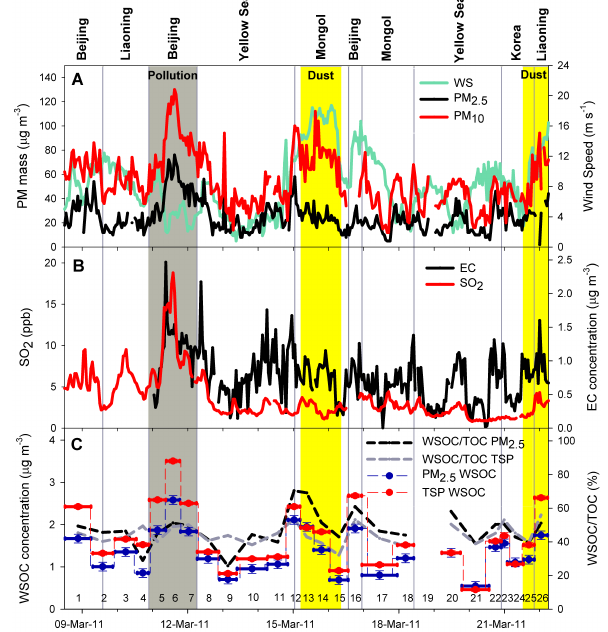
Fig. 2. Pollutant tracers and water-soluble organic carbon concen- trations during the March 2011 GoPoEx campaign at KCOG: ambi- ent air particulate mass (PM 2 . 5 and PM 10 ) and wind speed (A) ; con- centrations of SO 2 provided by South Korean National Institute of Environmental Research (NIER) and semi-continuously measured elemental carbon (EC) (B) ; concentrations of water-soluble organic carbon (WSOC) and WSOC to total organic carbon (TOC) ratio (C) in both ambient total suspended particles (TSP) and PM 2 . 5 fractions at KCOG during the GoPoEx campaign. The relation between pol- lutant tracers and back trajectory source regions are marked at the top. The pollution event is marked in grey and the dust events in